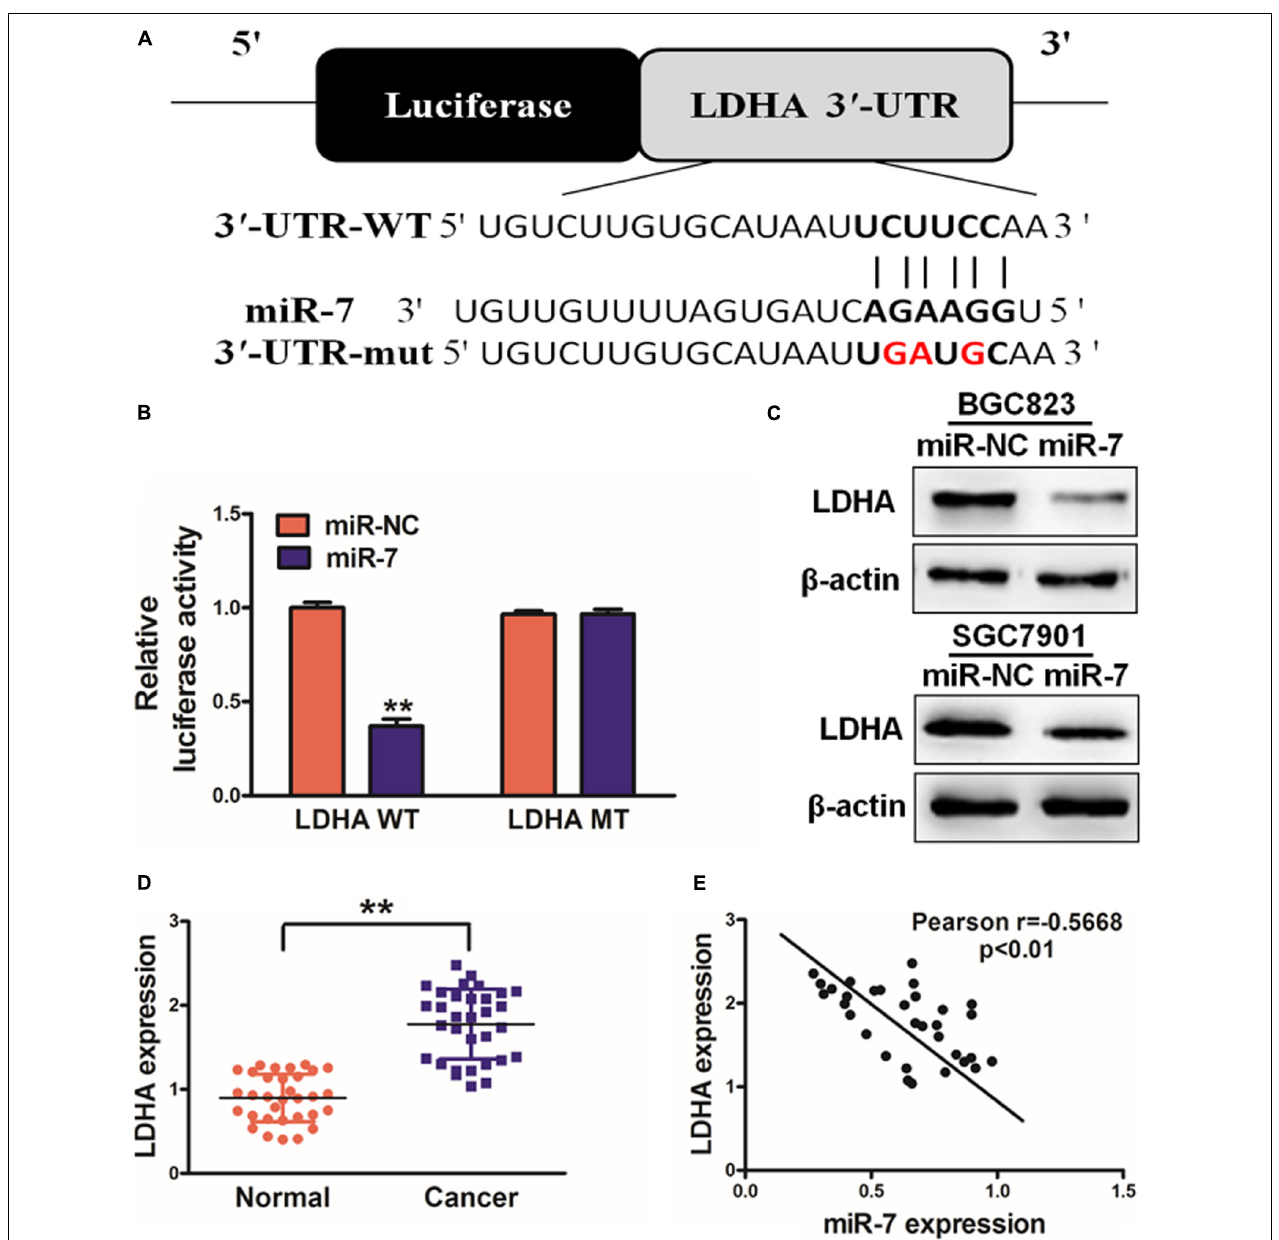
FIGURE 3 | miR-7 targets LDH-A in GC tissues. (A) Human miR-7 sequence aligned to the putative 3 (cid:48) UTR binding site in human LDH-A, with the mutated LDH-A sequence also shown (mutated nucleotides are red). (B) BGC823 were transfected with WT or mutant (MT) LDH-A 3 (cid:48) -UTR luciferase reporters along with miR-7 or miR-NC, and then after 24 h luciferase activity was assessed, revealing a miR-7-dependent suppression of WT promoter activity. Three independent experiments were conducted in triplicate. (C) Western blotting revealed reduced LDH-A expression in cells overexpressing miR-7. (D) LDH-A expression in human control and GC samples, measured via qRT-PCR with β -actin used for normalization. (E) The correlation between LDH-A and miR-7 in GC patient tissues was assessed via Pearson correlation analysis. Data are means ± SD. ** P <